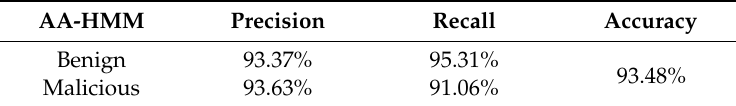
Table 8. Performance of